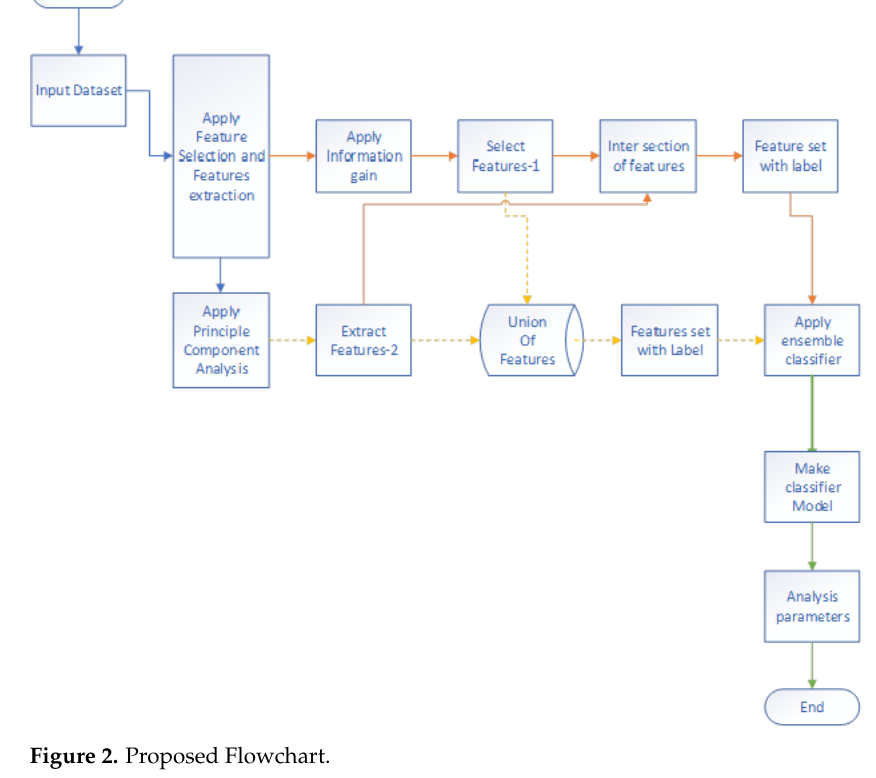
Figure 2. Proposed